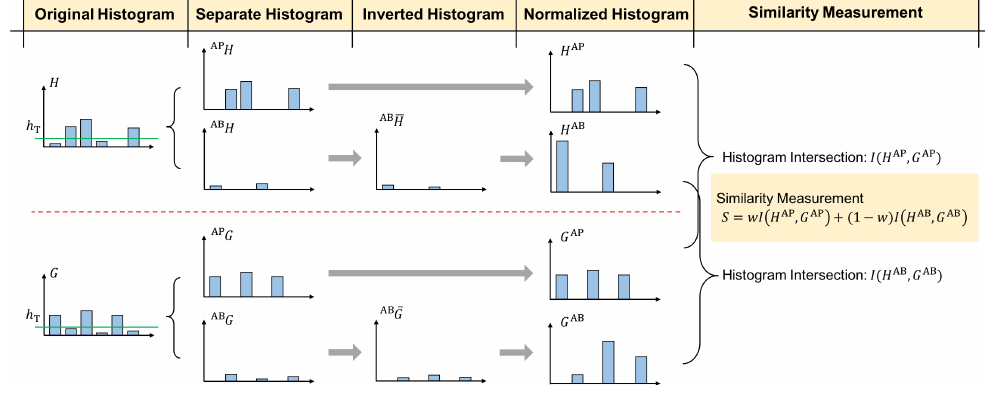
Figure 2. Methodology of ABC